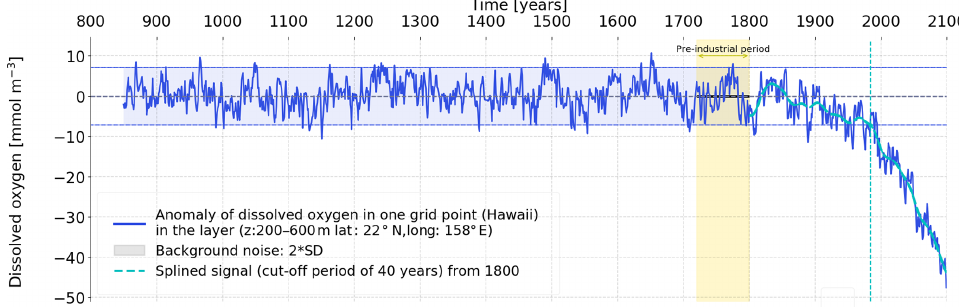
Figure A4. Illustration of the ToE method. The example is for the thermocline (200–600m) and grid cells located at 158 ◦ W and 22 ◦ N near Hawaii. The SD of the detrended, annually and vertically (200–600m) averaged data (blue) for the period 850–1800CE is used to define the “noise” or bounds of natural variability which is set to ± 2SD (blue area). The annually and vertically averaged data are fitted with a spline using a cut-off period of 40 years (light blue). ToE is the point in time when the spline crosses and leaves the bounds of natural variability; here, ToE is 1984 and indicated by the vertical dashed line. All data are anomalies relative to the pre-industrial period (1720–1800CE; yellow).